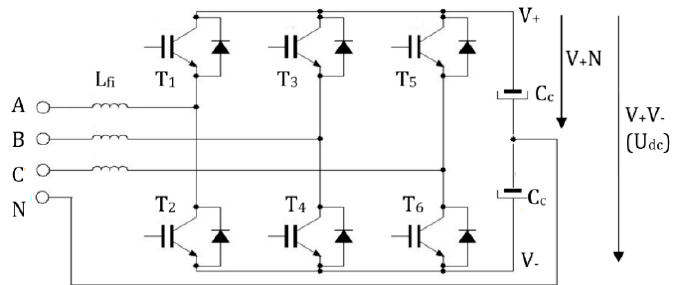
Figure 8. The power structure of SAPF.